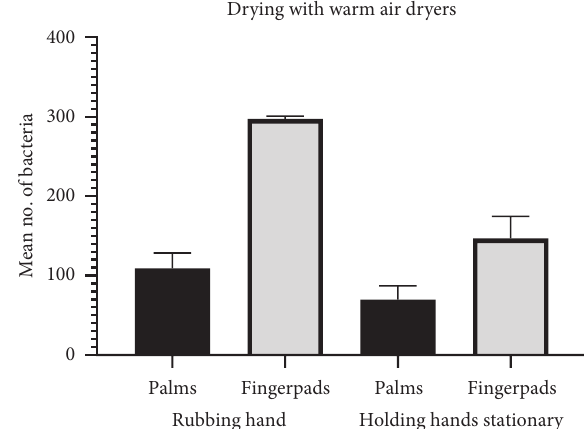
Figure 2: The mean number of bacteria obtained from the par- ticipants’ hands upon washing and drying with air dryer while holding stationary hands and drying with air dryer during hand